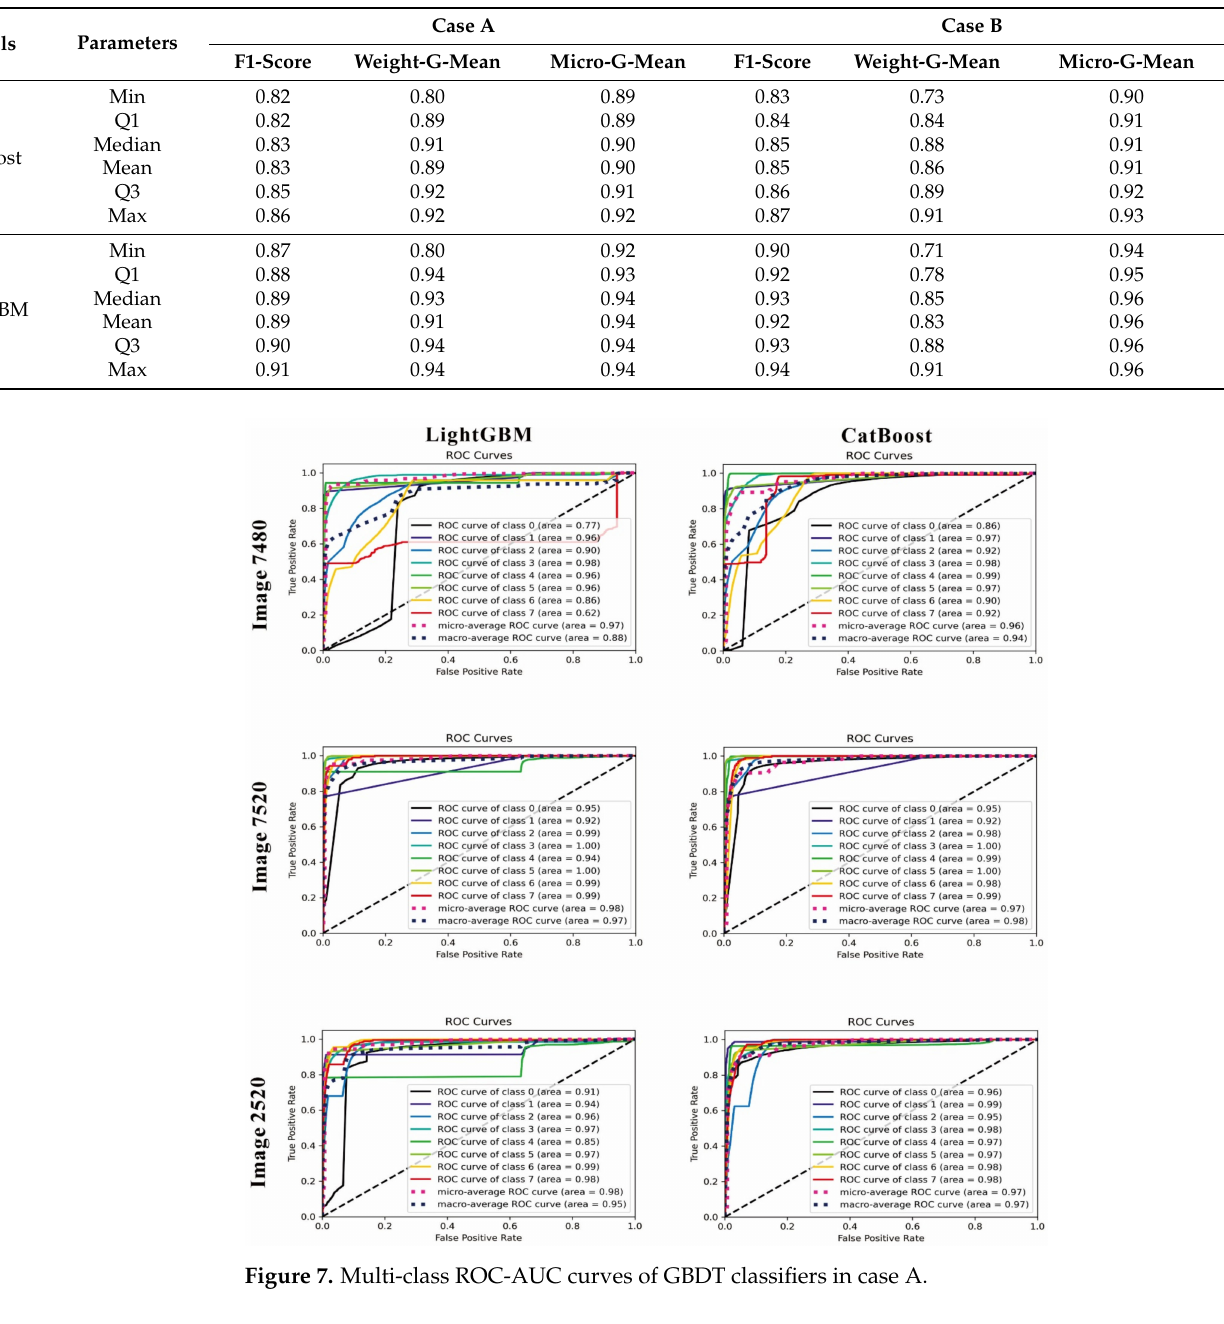
Table 2. Statistic parameters of used GBDT models.